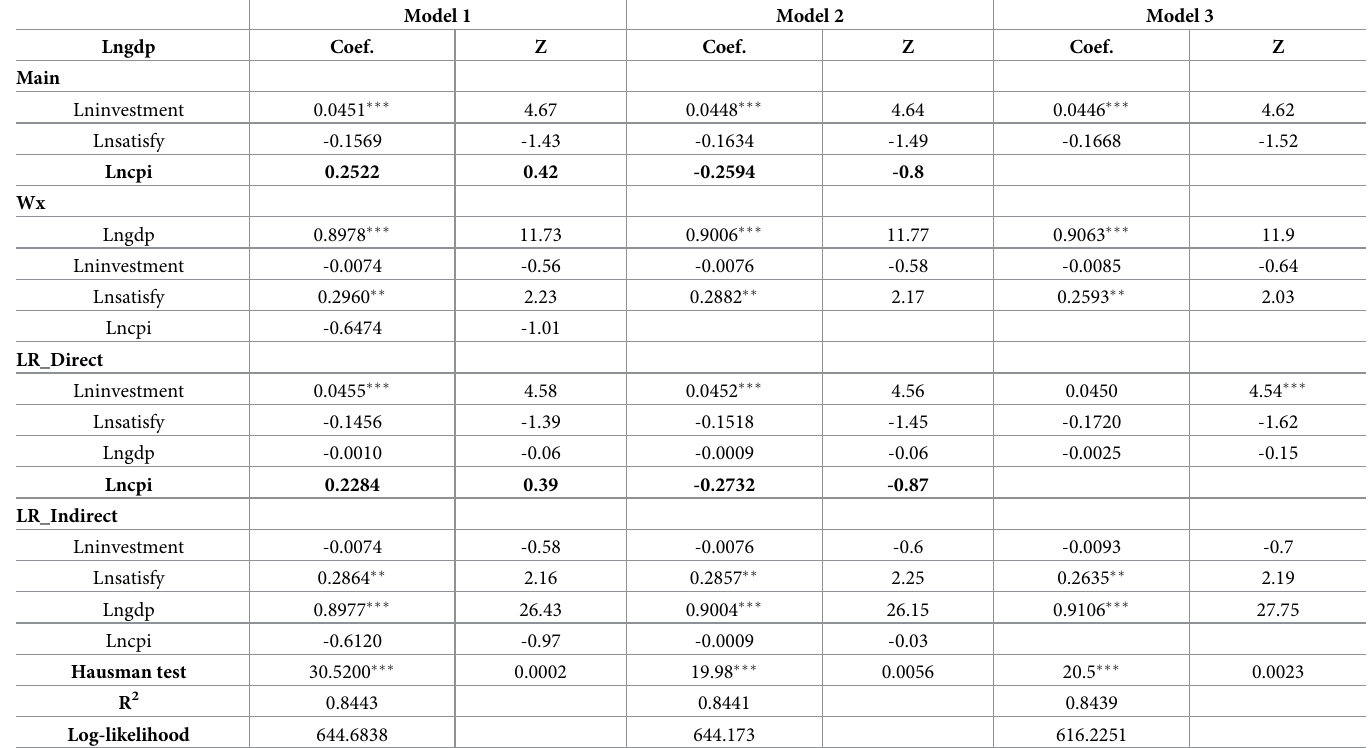
Table 6. SDM regression results for urban tourist satisfaction and urban